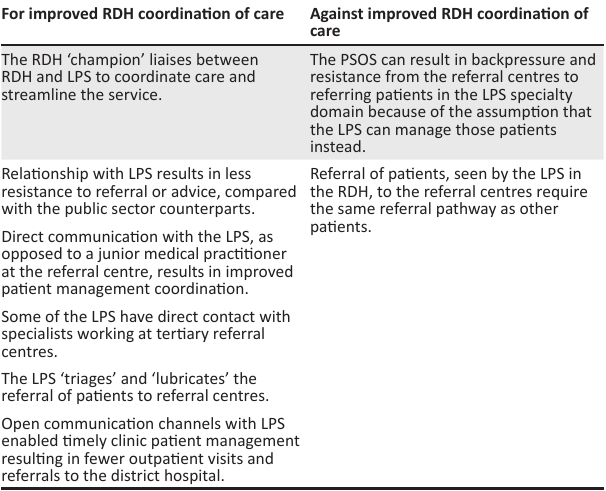
TABLE 4: Private specialist outreach and support factors for and against improved rural district hospitals coordination of care. For improved RDH coordination of